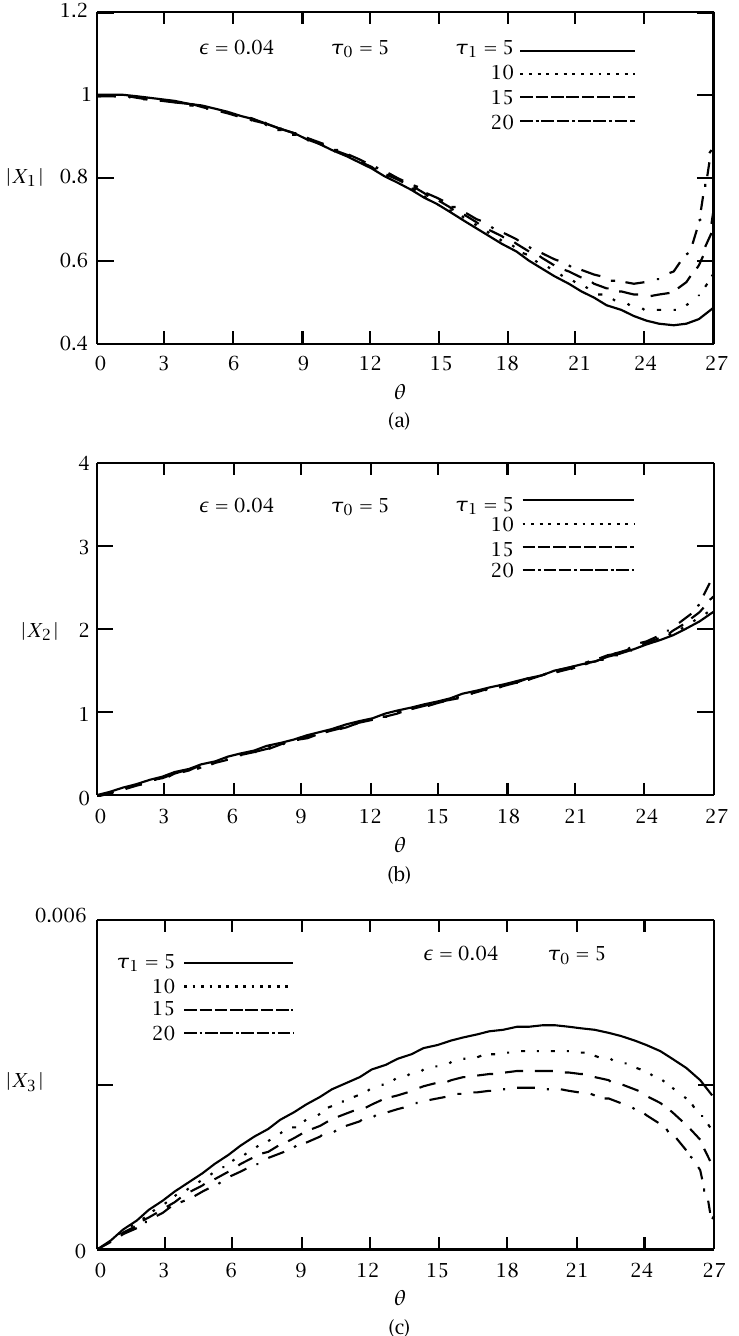
Figure 3 . (The effect of the thermal relaxation times in G-L theory) | X 1 | , | X 2 | , | X 3 | versus the angle of incidence θ